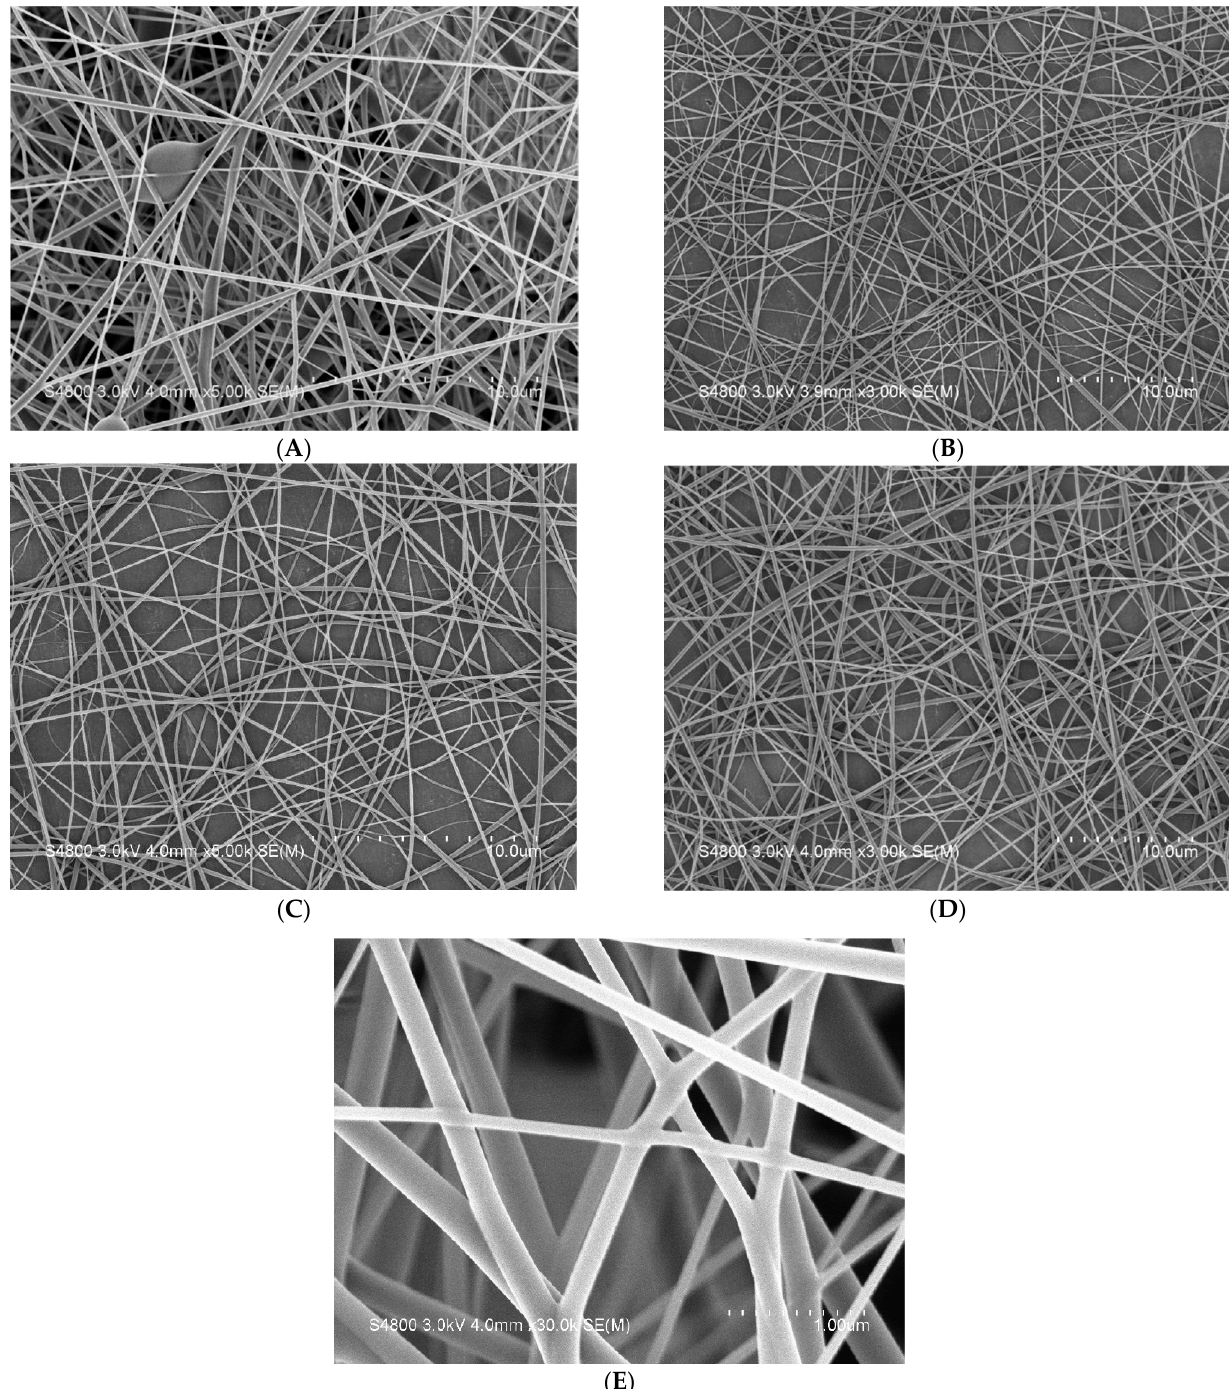
Figure 5. SEM images (magnification of 3 K) of PVP/CS/ P. emblica nanofiber membranes of ( A ) PVP/CS/ P. emblica 0 wt%, ( B ) PVP/CS/ P. emblica 0.005 wt%, ( C ) PVP/CS/ P. emblica 0.01 wt%, and ( D ) PVP/CS/ P. emblica 0.02 wt%. ( E ) PVP/CS/ P. emblica 0 wt% (magnification of 30 K).